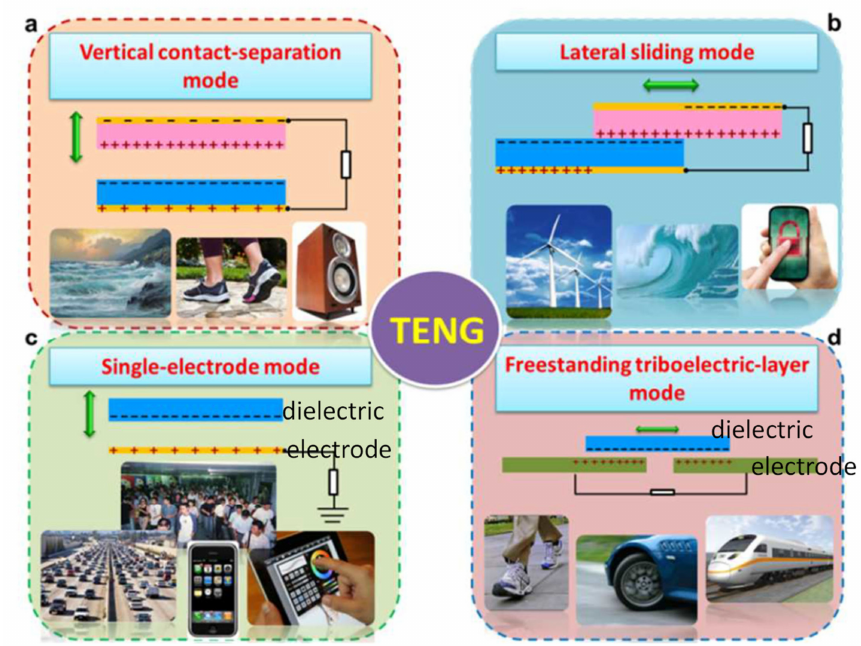
Figure 9. Four basic modes of operation in triboelectric nanogenerators: ( a ) vertical contact separation mode, ( b ) side-sliding mode, ( c ) single-electrode mode, and ( d ) standalone mode. Reproduced with permission from [73], Copyright 2015, Royal Society of